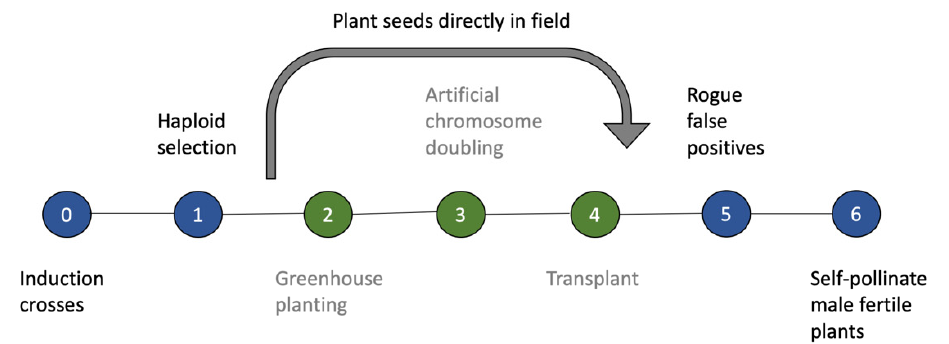
Figure 3. Pipeline for doubled haploid production, using SHGD as an alternative to artificial genome doubling agents. Green shading indicates stages of a traditional doubled haploid (DH) pipeline that are replaced by direct seeding into the field when utilizing